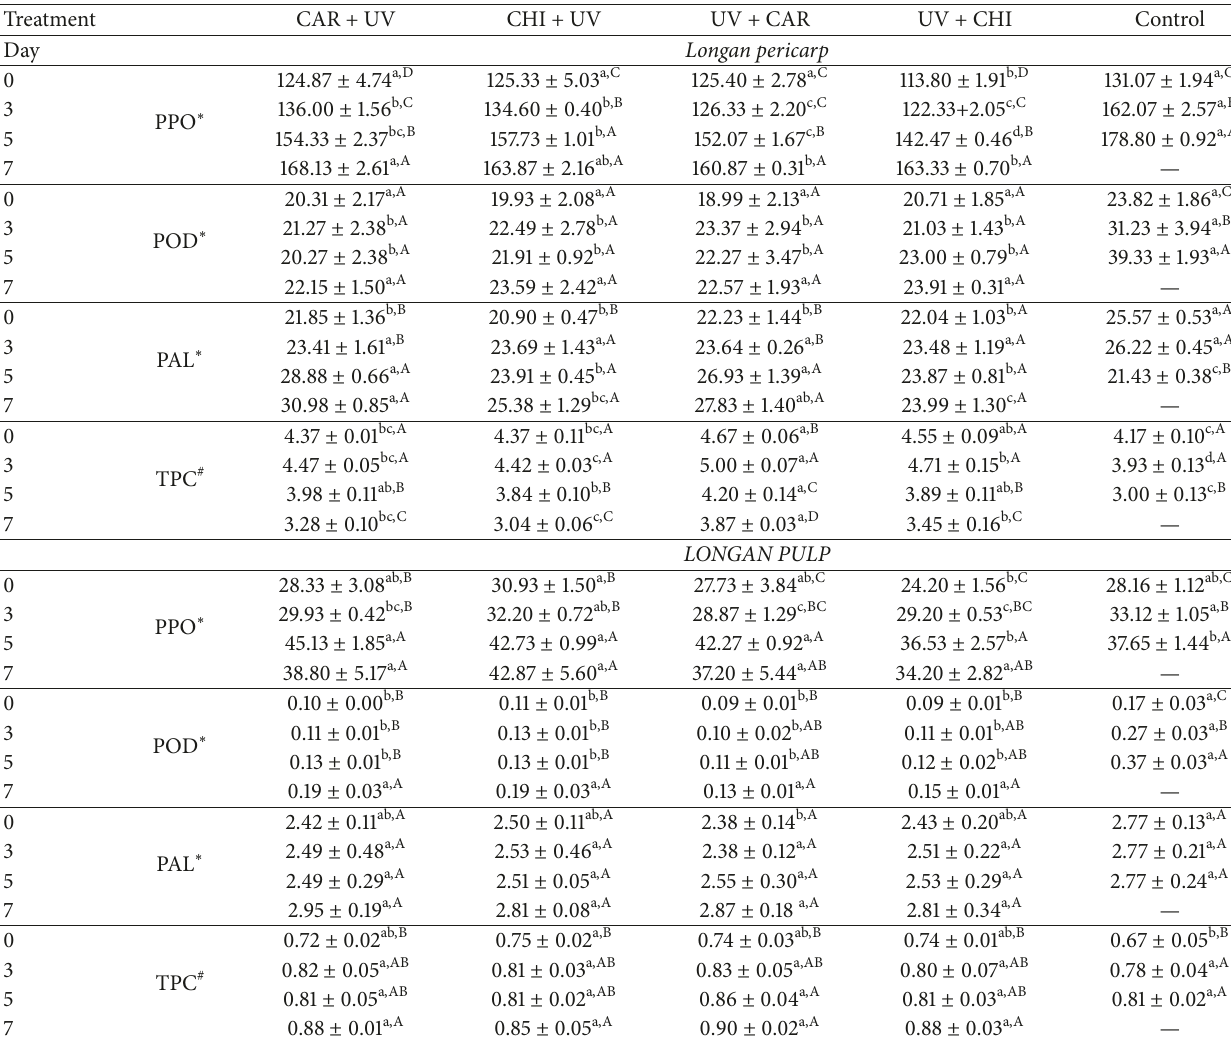
Table 4: The effect of different UV-C and edible coating combinations and sequences (together with control) on the TPC and enzymatic activities (PPO, POD, and PAL) of longan fruit pericarp and